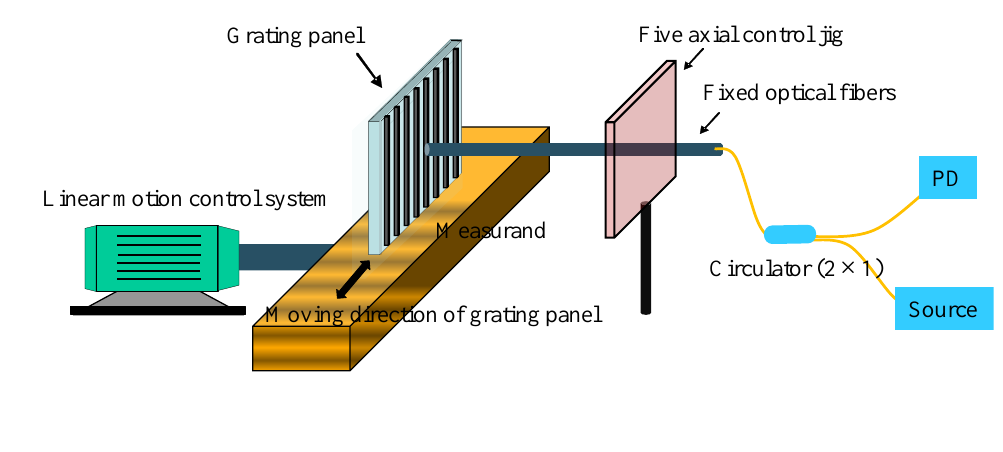
Figure 7. Configuration of the experimental